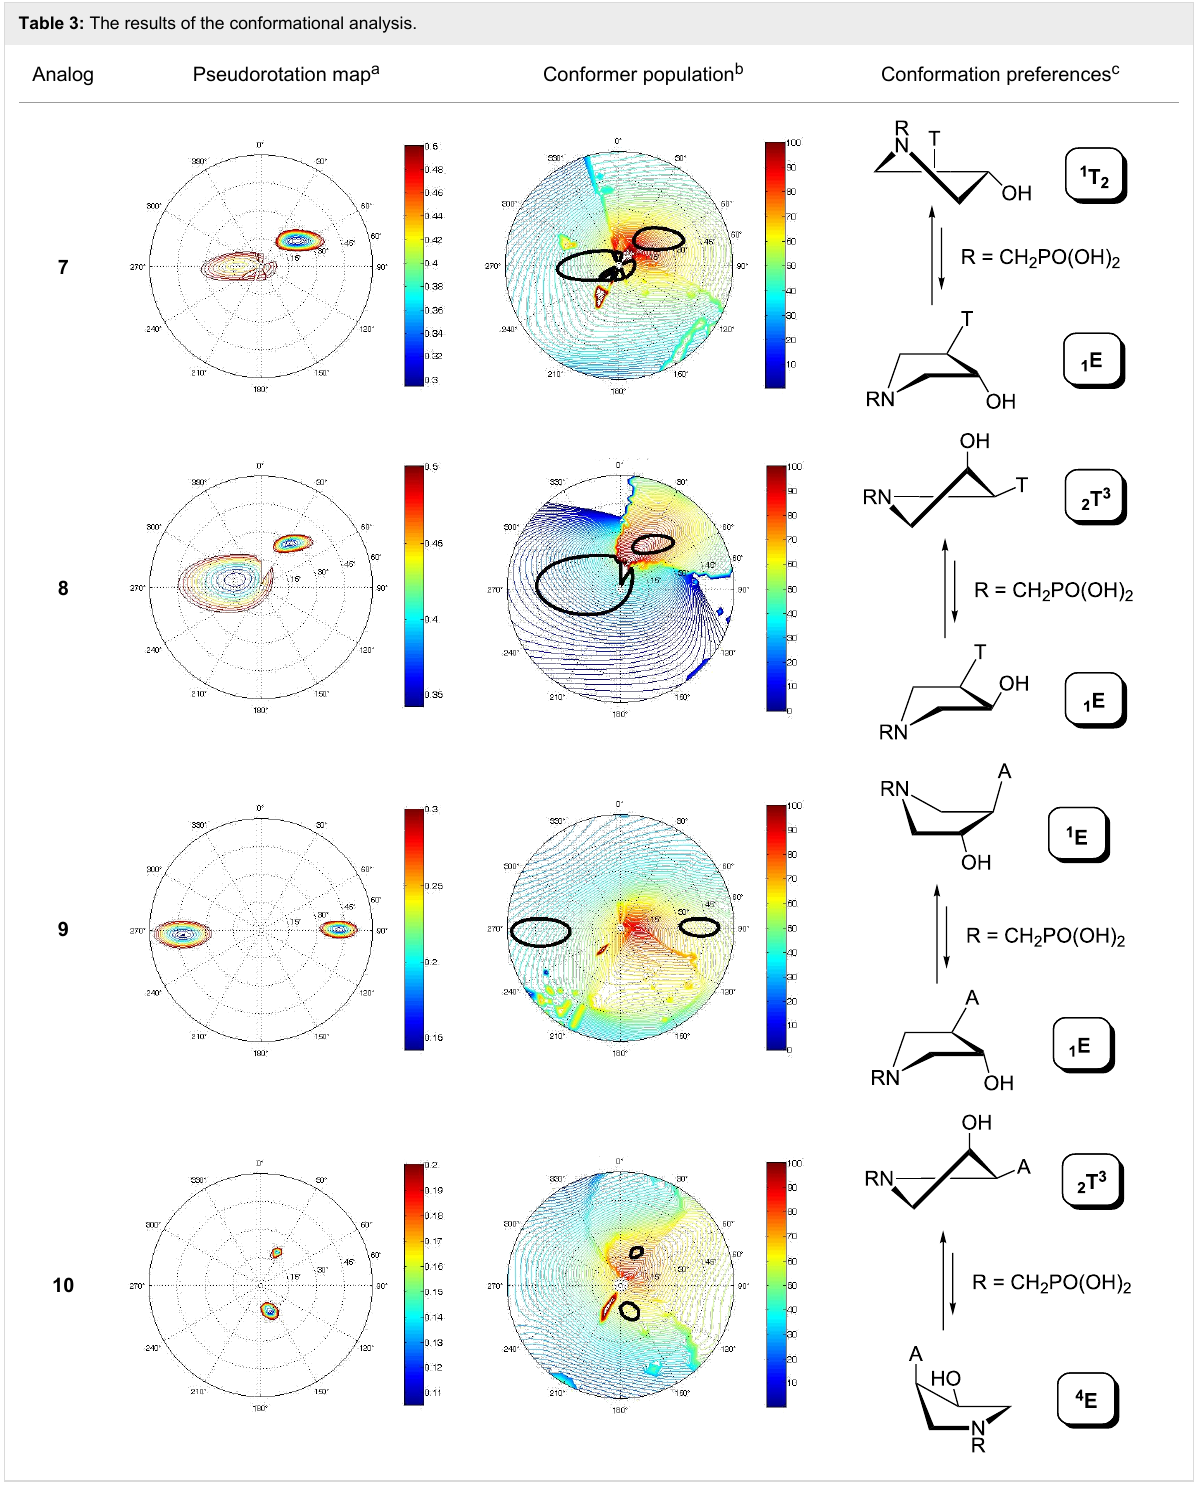
Table 3: The results of the conformational